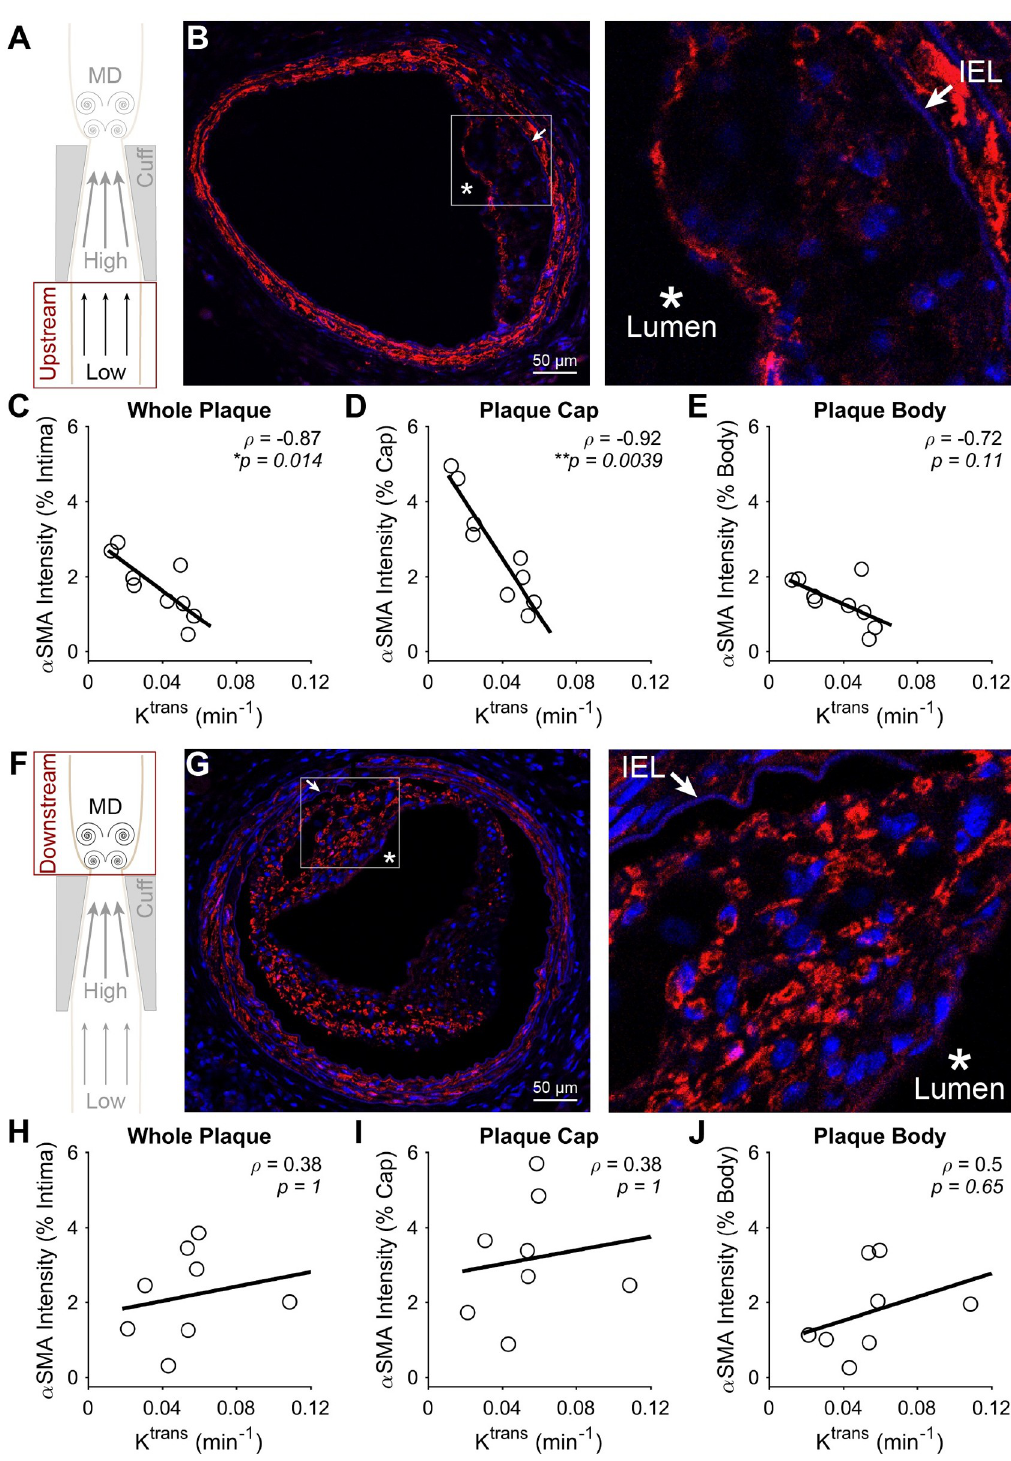
Fig 7. Correlation between α -SMA and NP accumulation assessed via K trans at 9 weeks after cuff placement. (A) Diagram of the instrumented carotid artery highlighting the focus of this part of the figure on the low WSS (upstream) region. (B) A representative histology section and higher magnification insert of the plaque region, where the lumen and IEL are identified. (C-E) The correlation between α -SMA and K trans in different regions of the plaques induced by low WSS, including the (C) entire plaque, (D) plaque cap (13.3 μ m), and (E) plaque body minus the cap. (F) Diagram of the instrumented carotid artery